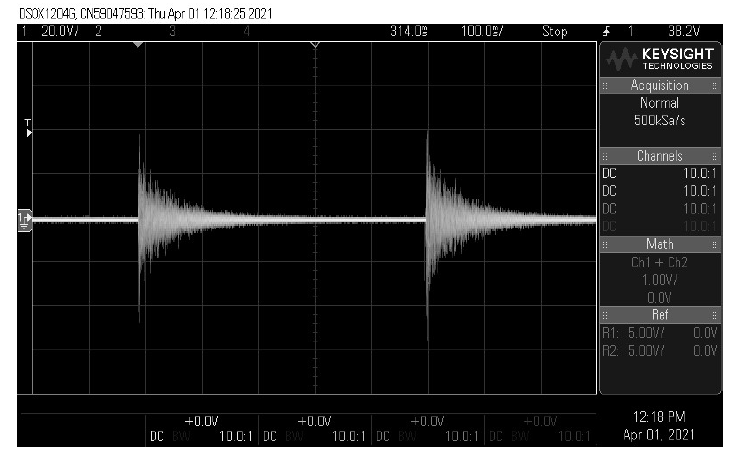
Fig. 5. Received signal oscillogram.